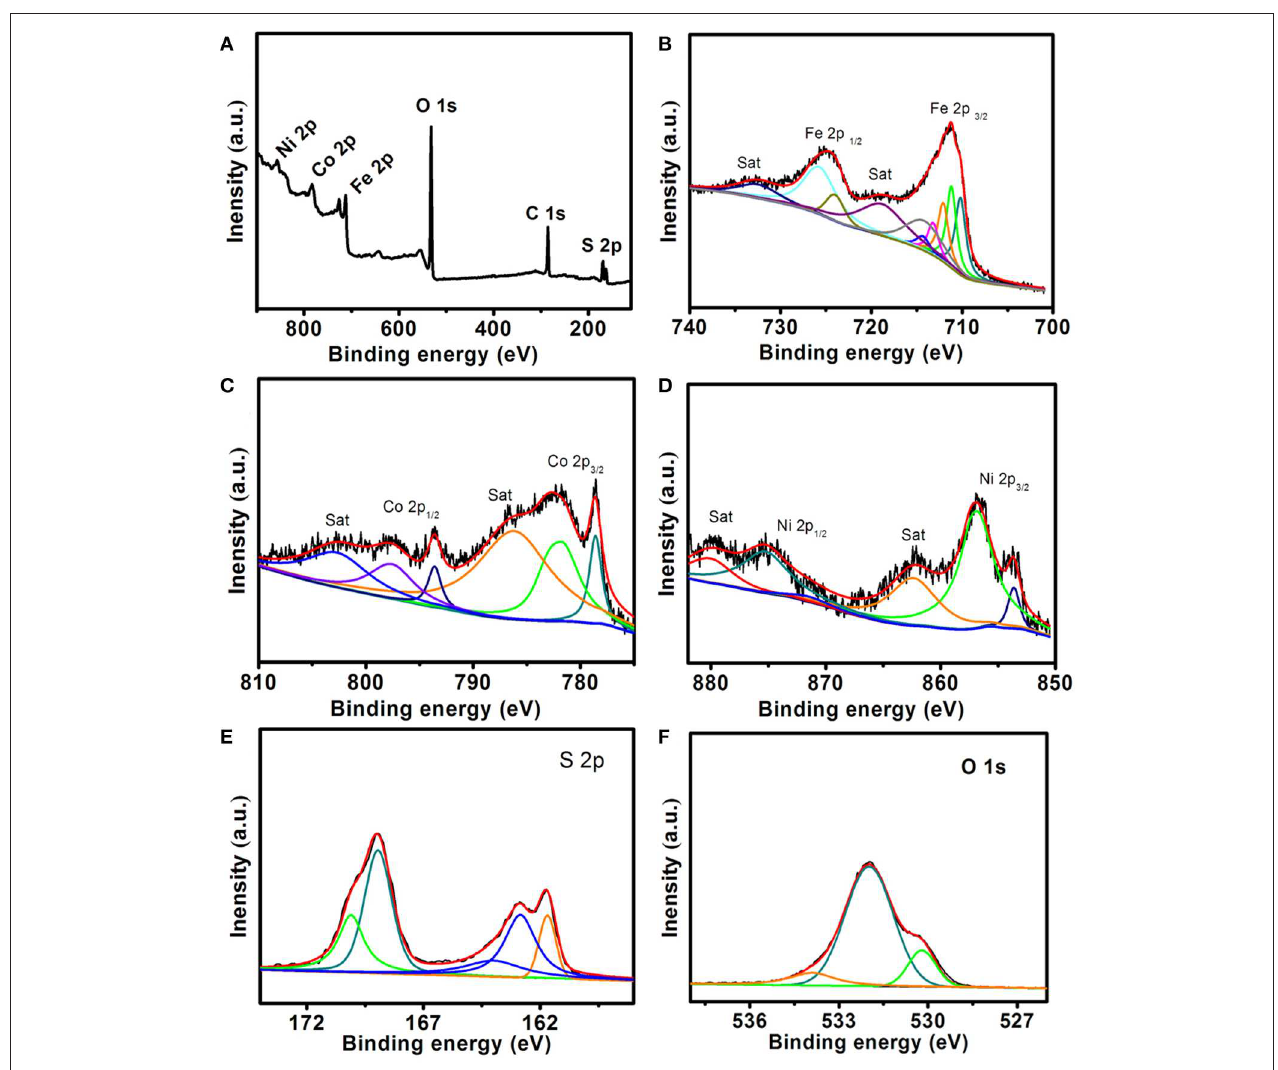
FIGURE 4 | X-ray photoelectron spectroscopy (XPS) spectra of FeCoNiS-FeO x catalyst. (A) Survey spectrum. (B) Fe 2p. (C) Co 2p. (D) Ni 2p. (E) S 2p. (F) O